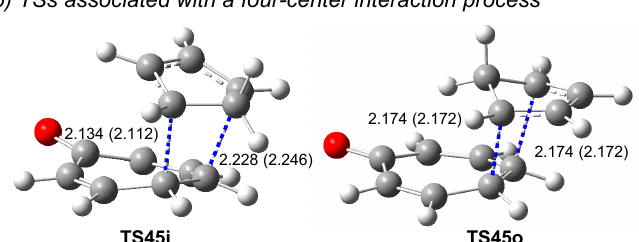
Figure 4. ω B97X-D/6-311G(d,p) geometries of the TSs involved in the cycloaddition reaction of tropone 1 with Cp 3 . Distances are given in angstroms. The two-center interactions at the TSs are remarked in red, while the four-center interactions are in blue. Lengths in benzene are given in parentheses. Interestingly, pseudocyclic TSs TS25i and TS27o show a different degree of asynchronic- ity at ∆ l = 0.95 and 0.62 Å, respectively. This remarkable change of asynchronicity in these TSs is a consequence of two opposite electronic factors; while the favorable electronic interaction between the Cp framework and the carbonyl O8 oxygen brings them closer in out TS27o , the unfavorable electronic interaction between the Cp framework and the unsaturated ring of tropone 1 in in TS25i pushes them farther apart. permits assessing the polar character of this cycloaddition reaction [47]. GEDT values